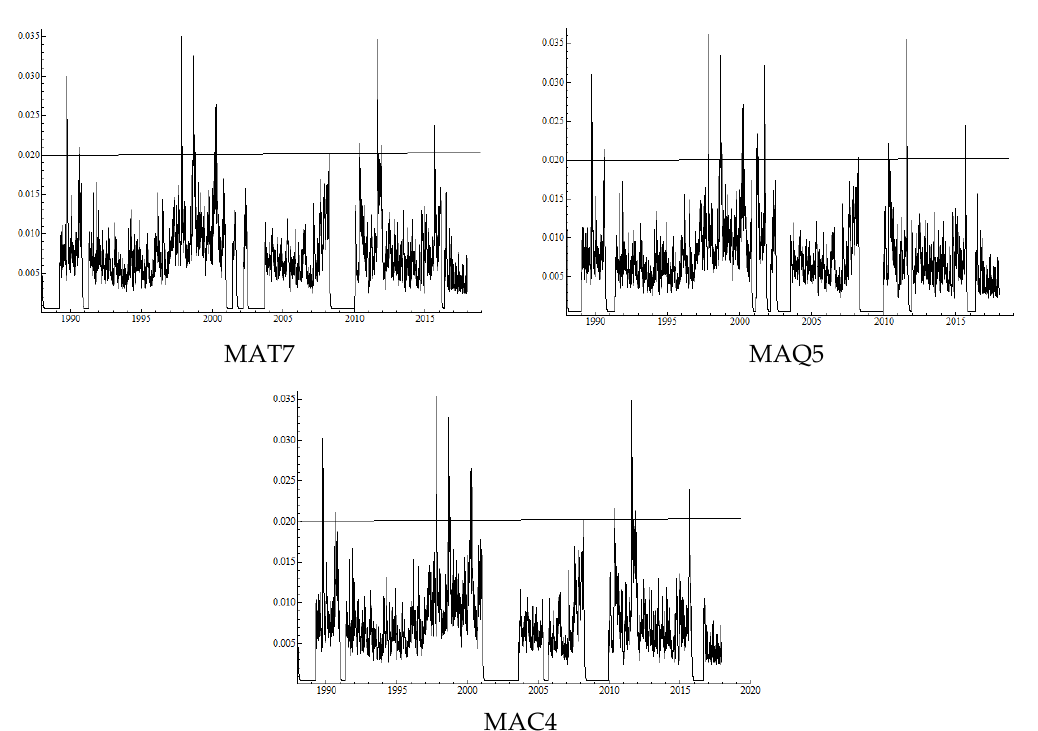
Figure 2. Realized volatilities in 400 trading days rolling window are used. The straight line is the 2% realized volatility bound.